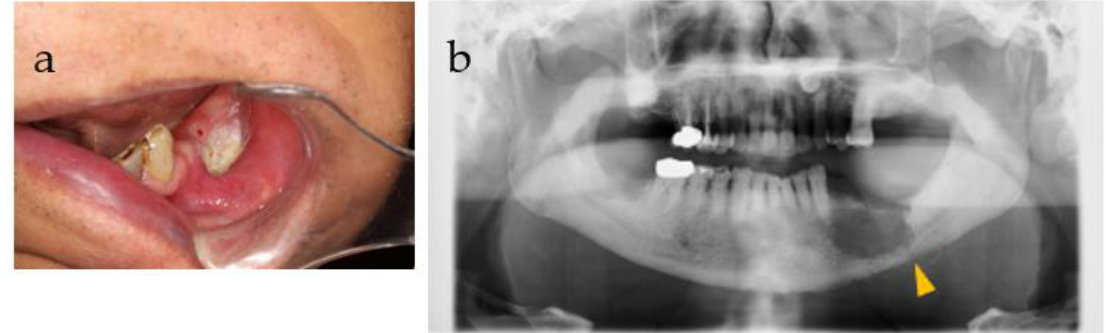
Figure 5. ( a ) Intraoral photograph and ( b ) panorama X-P before and after a pathological fracture. A keratinized substance was found in the oral cavity, and the sixth histopathological examination confirmed that it was a keratinized substance. Furthermore, a pathological fracture was observed (yellow triangle).